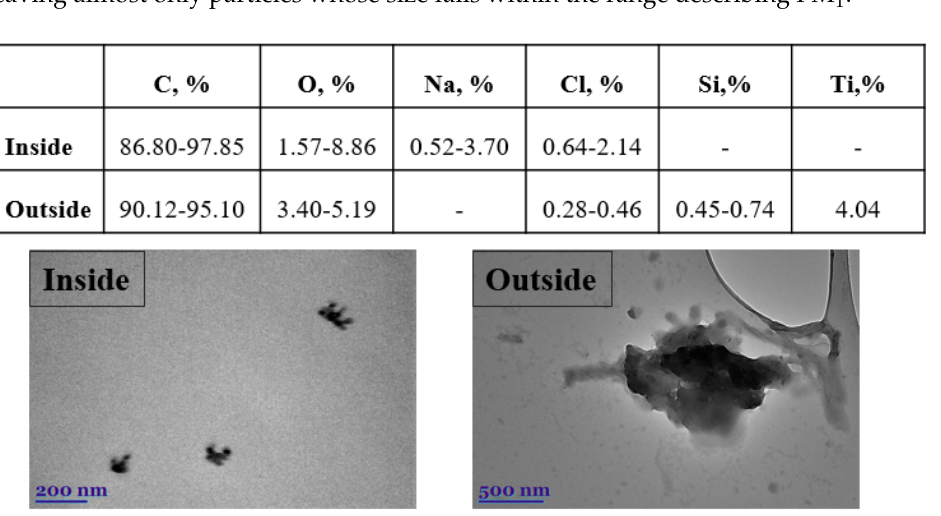
Figure 9. TEM images and EDX data of individual inside/outside particles.